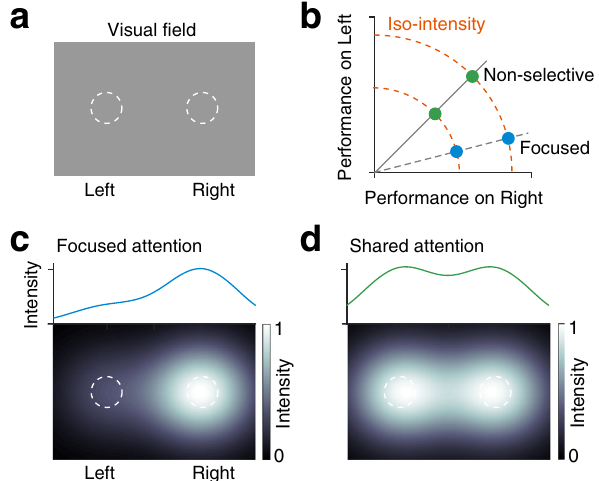
Fig. 1 Attentional components, selectivity and intensity. a Visual fi eld. Dashed circles, locations of visual spatial attention. b Attention operating characteristic (AOC). The spatial distribution of performance, as visual attention is being shared between the two locations, left and right. Green circles, attention is equally shared between the left and the right location with no selectivity. Blue circles, selective attention is directed toward the right location. Dashed arcs, path of constant intensity of attention (iso- intensity). c Bottom, simulated spatial distribution of attentional intensity when attention is focused in right. Top, average attentional intensity along horizontal. d Same as in ( c ), for equally shared attention between left and